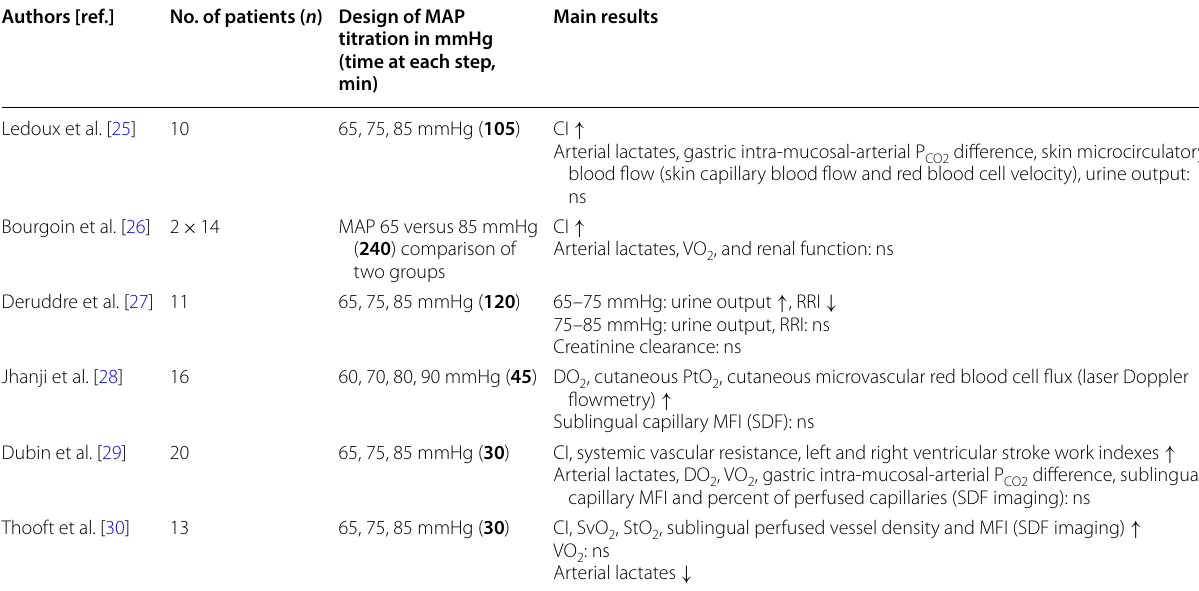
Table 1 Prospective studies with MAP titration and peripheral (microcirculatory) or targeted tissue/organ perfusion assessment in septic